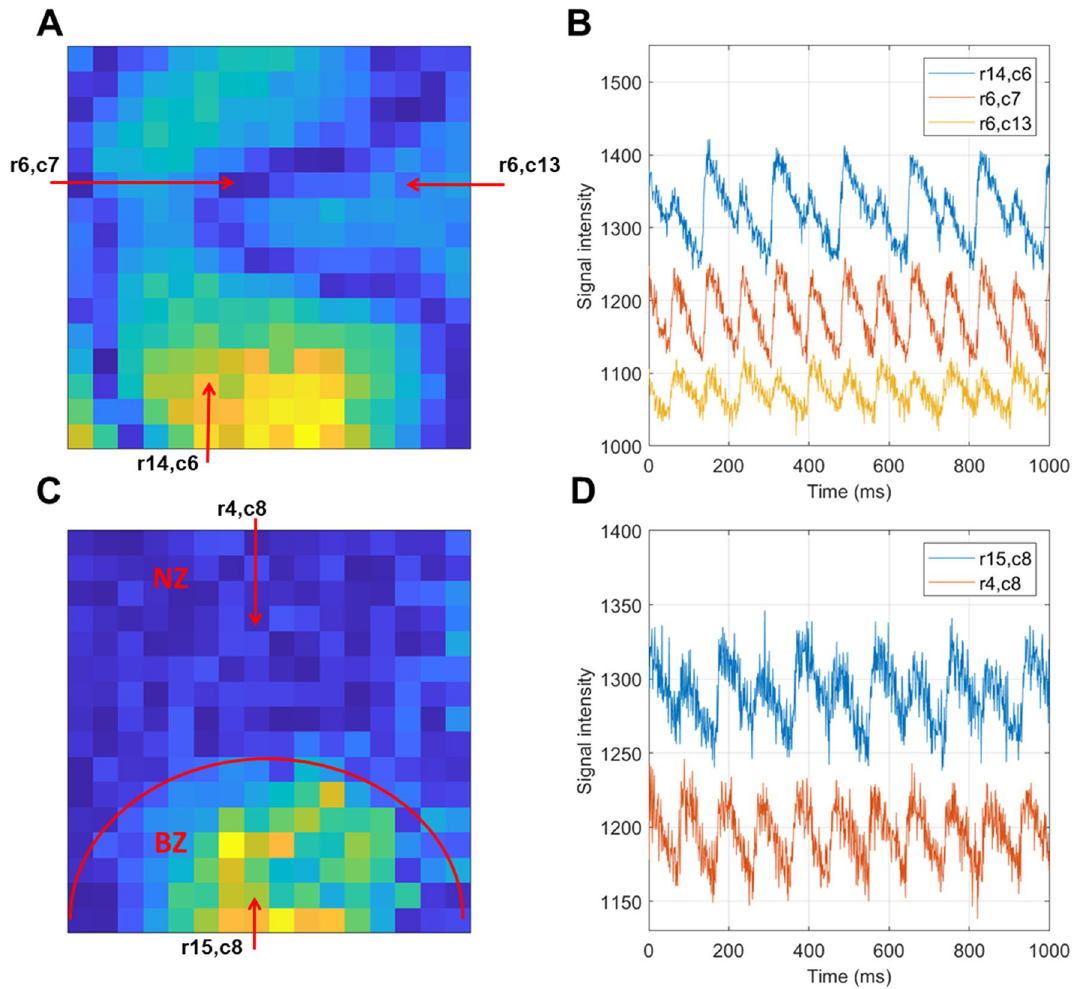
Figure 6. Examples of alternans maps and traces. ( A ) Calcium transient amplitude alternans map corresponding to discordant alternans, with warmer colors corresponding to alternans with large amplitude. Dark blue zones are nodal lines separating zones of alternans in opposite phases. The pixels marked by red arrows with annotations giving the row and column indices are used in the subsequent panel. ( B ) Sample traces from the three marked pixels in the recording in ( A ), verifying that the alternans is discordant (blue and yellow traces have opposite phases) and that there is a lack of alternans in the nodal lines (red trace). ( C , D ) Similar format to ( A , B ), but showing spatially heterogeneous alternans in an infarcted heart, where alternans arises only in the infarct border zone (BZ) but not the non-infarcted zone